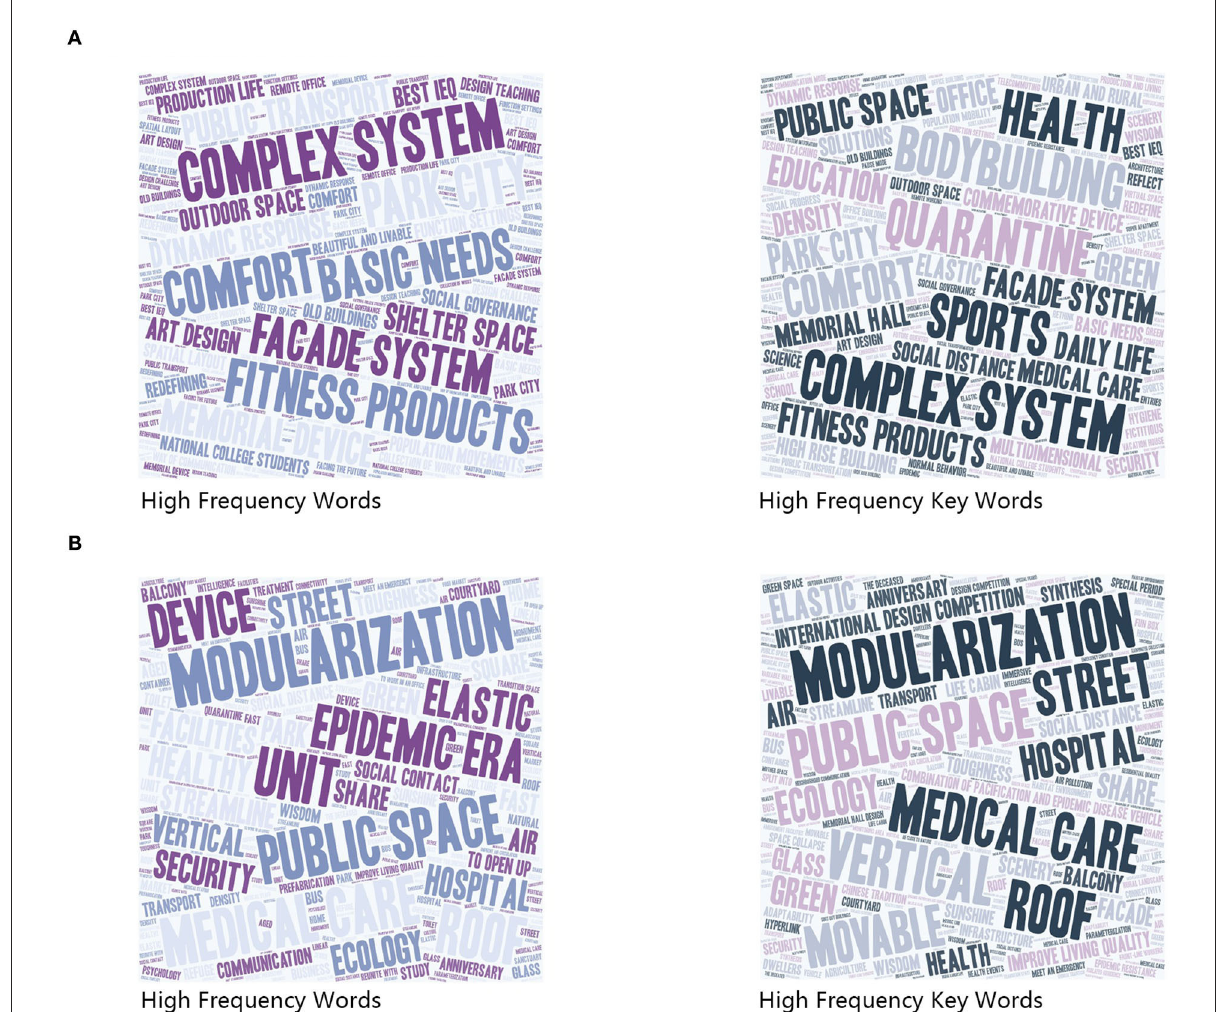
FIGURE2 Competition themes and works high frequency words word cloud. (A) The themes word cloud. (B) The words word